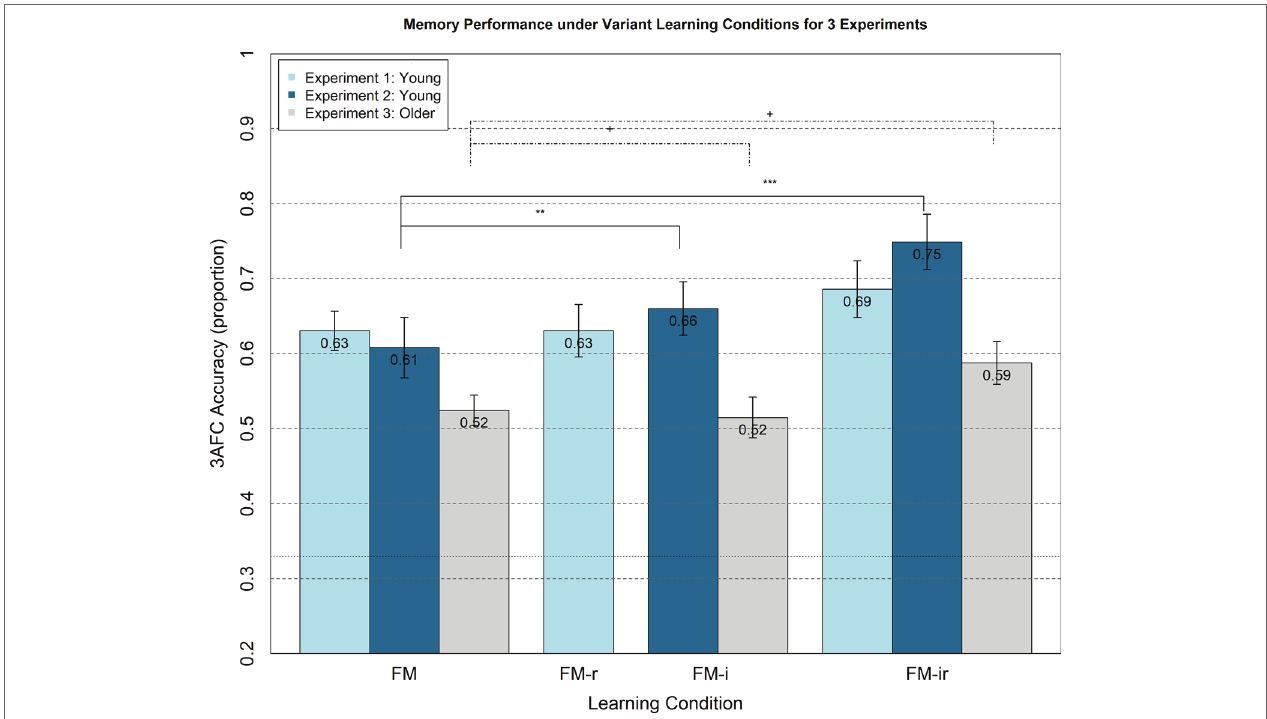
FIGURE 2 | Memory performance in Experiments 1–3 from 3AFC at the test phase (chance = 0.33) for FM variants administered within-participant. Experiment 1 (light blue bars) shows memory performance for healthy young adults under FM, FM-r, and FM-ir; there were no significant differences between conditions. Experiment 2 (dark blue bars) shows memory performance for a different group of healthy young adults under FM, FM-i, and FM-ir. Significant differences are marked ** = p < 0.01, *** = p < 0.001. Experiment 3 (grey bars) shows performance of healthy older adults under same conditions as Experiment 2. Trending differences are marked + = p < 0.064. Mean performance is reported at the top of each bar. Error bars are standard error of the